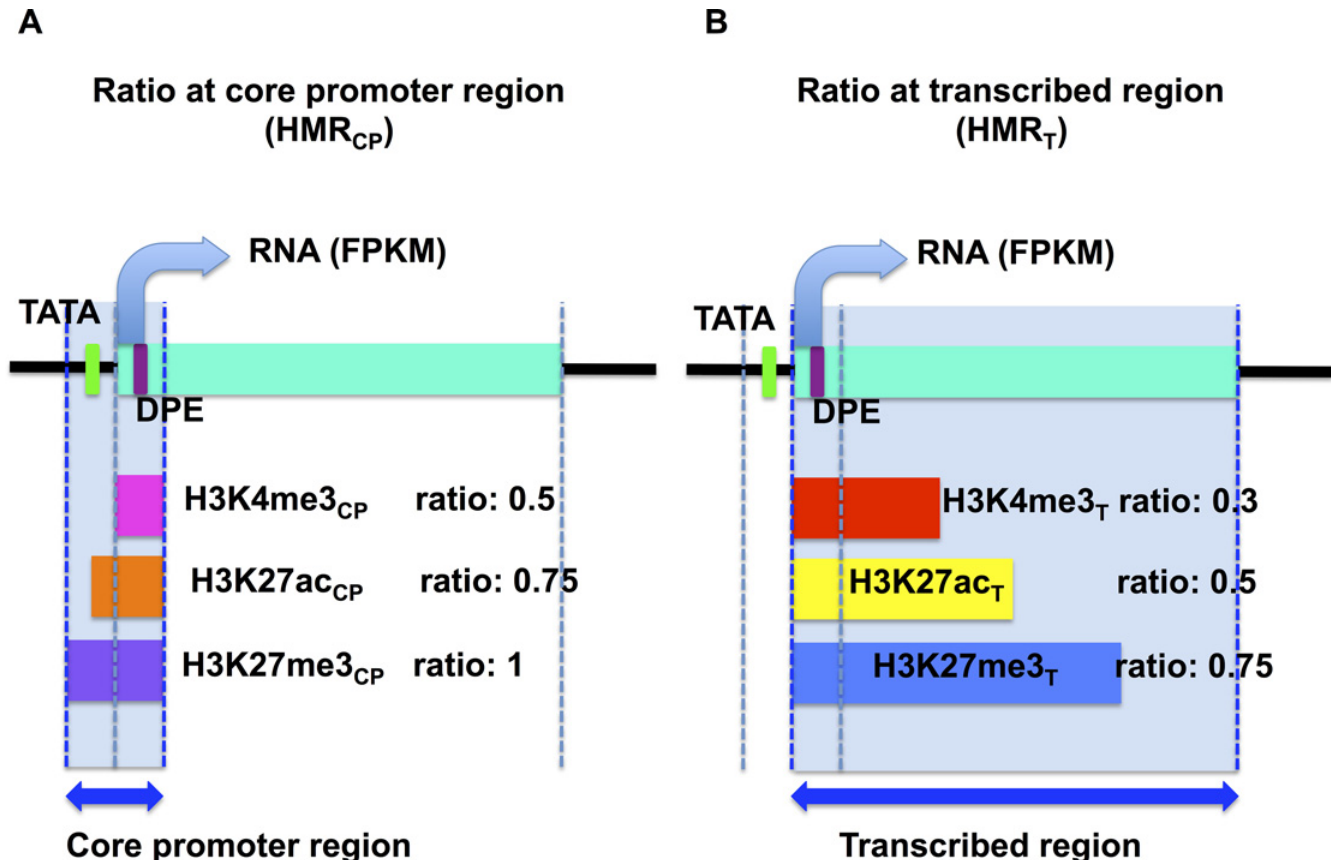
Fig 1. Diagram of histone modification ratios. The green bar represents the transcribed region, and the dotted lines represent the 5 0 terminal of the core promoter, +1 position (TSS), 3 0 terminal of the core promoter, and transcription end site (TES), from left to right. (A) Histone modification ratios at the core promoter region. The pink bar represents the region with H3K4me3, the orange bar represents the region with H3K27ac, and the purple bar represents the region with H3K27me3 within the core promoter region. The ratios of these bars to the area of the core promoter region filled with light blue were calculated. (B) Histone modification ratios at the transcribed region. The red bar represents the region with H3K4me3, the orange bar represents the region with H3K27ac, and the purple bar represents the region with H3K27me3 within the transcribed region. The ratios of these bars to the area of the core promoter region filled with light blue were